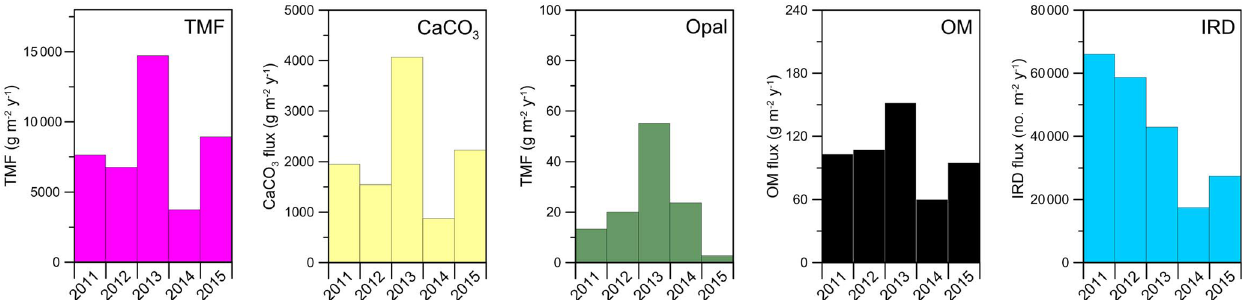
Figure 9. Annual fluxes of total mass and major components.